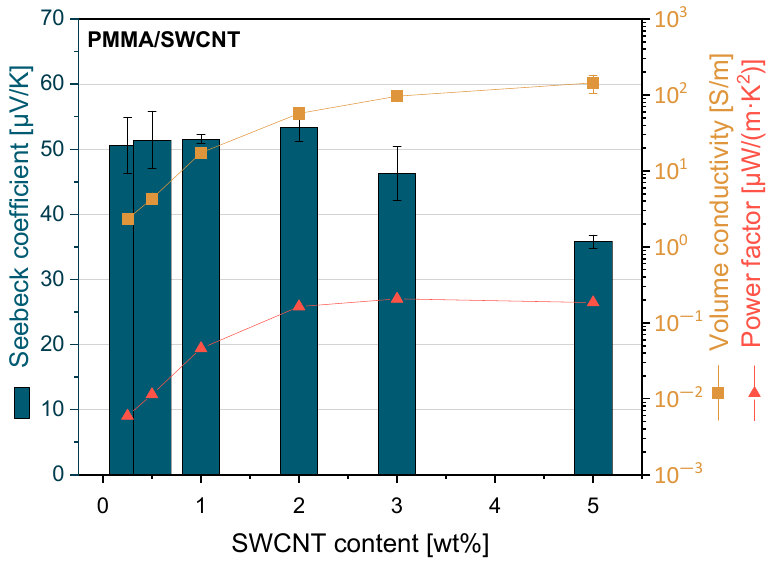
Figure 7. Thermoelectric properties of PMMA/SWCNT composites prepared by direct incorporation at a rotation speed of 250 rpm.